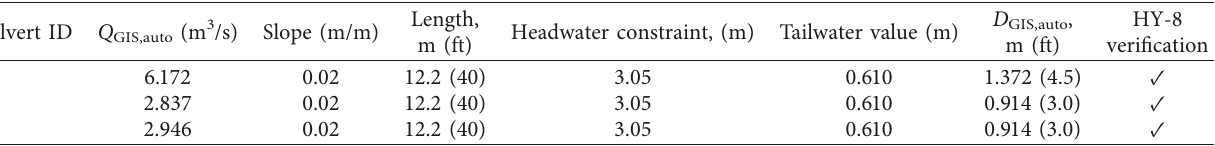
Table 4: Quality assurance for three culvert diameters.